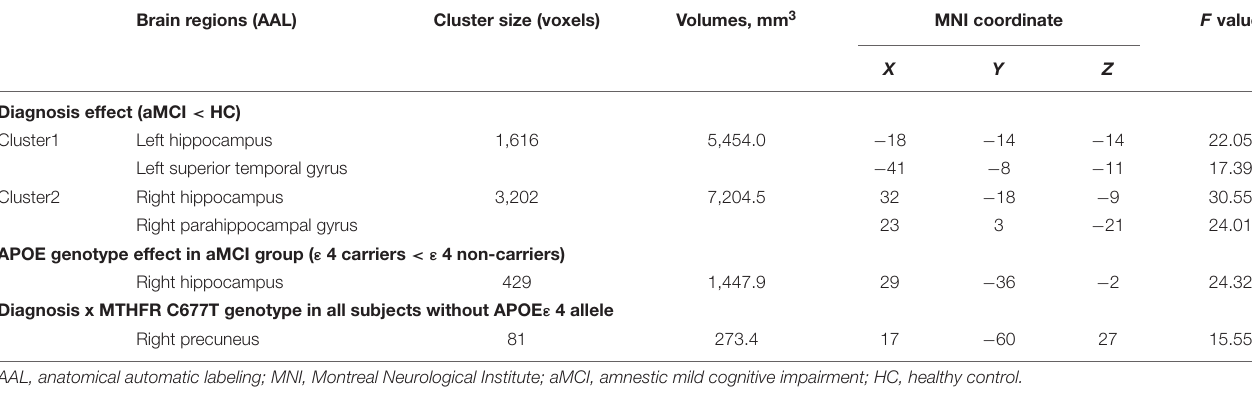
TABLE 2 | Significant clusters showing the effects of aMCI and genotype on gray matter volume.